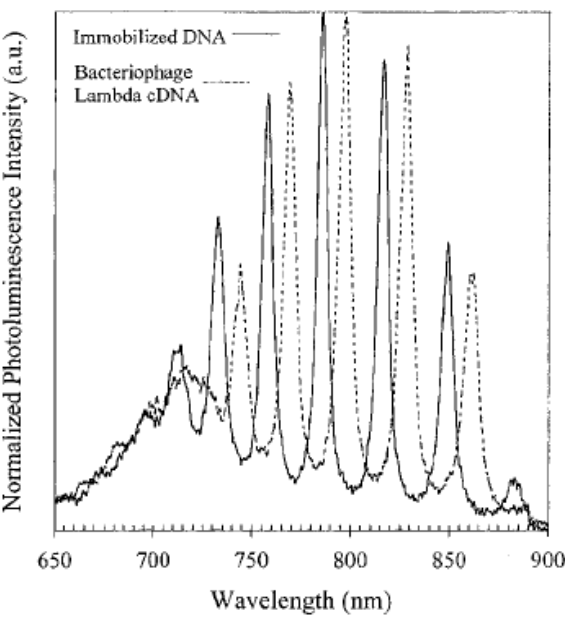
Figure 9. Recognition and binding of bacteriophage lambda DNA to a 30-nucleotide complementary DNA sequence immobilized on a silicon chip is detected by a 12 nm red- shift in photoluminescence. The DNA concentration of the sensing bacteriophage lambda is 194.2 fM. Reproduced from [43]. Copyright Wiley-VCH Verlag GmbH & Co. KGaA. Reproduced with